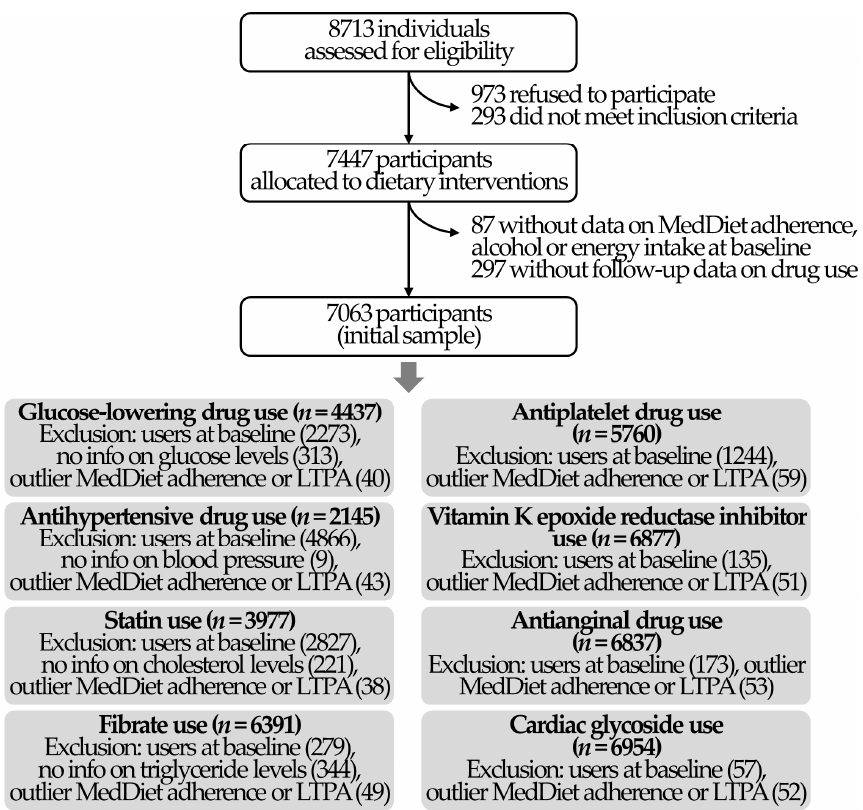
Figure 1. Study flowchart. LTPA: leisure-time physical activity; MedDiet: Mediterranean diet.